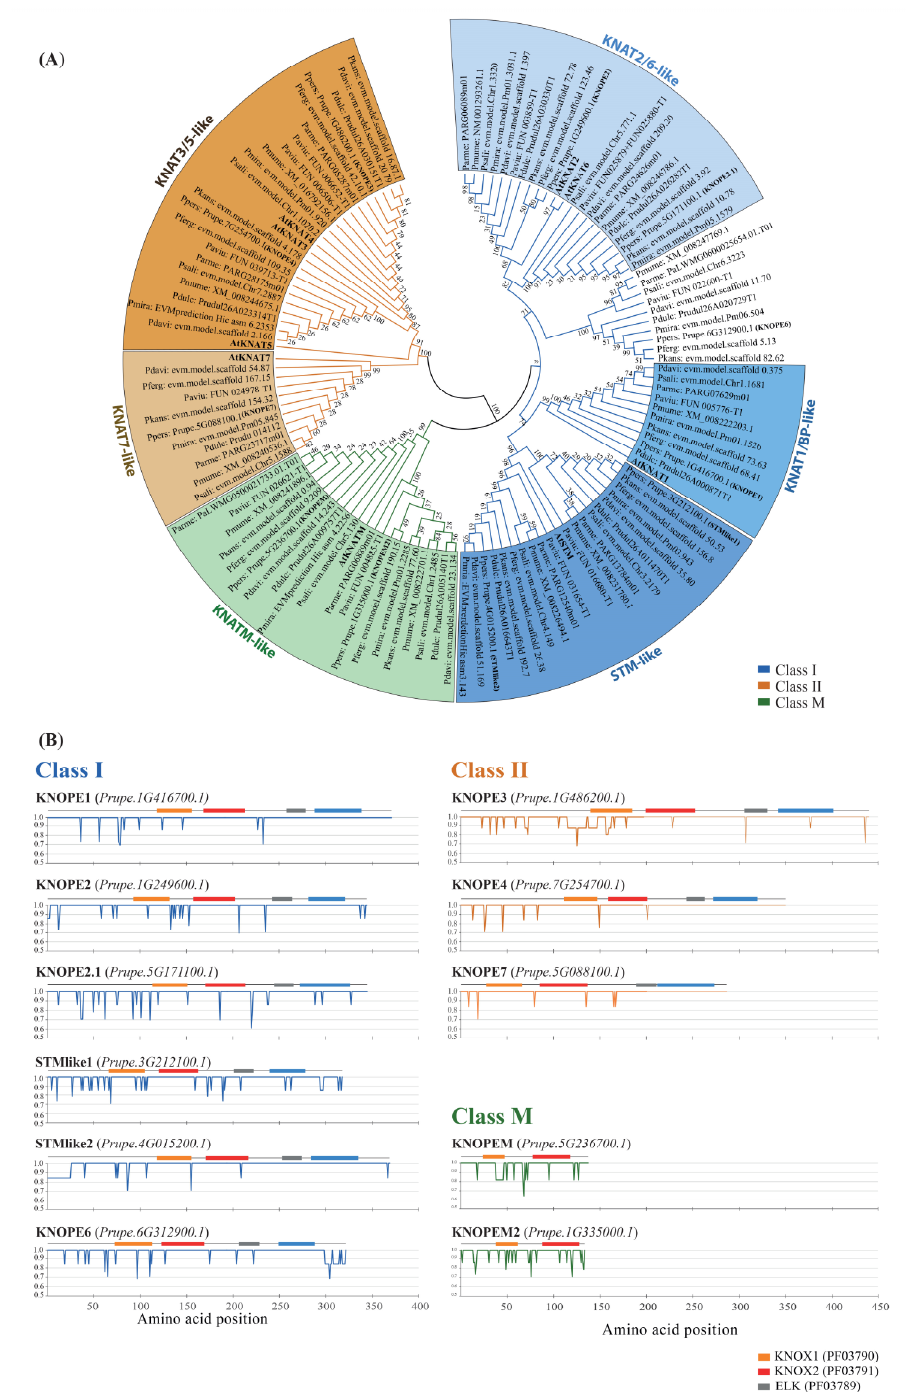
Figure 1. ( A ) Phylogenetic tree of PRUNOX deduced proteins, clustered into classes I, II, and M (blue, orange, and green shades) and named based on the presence of A. thaliana (bold) members in the clade. ( B ) Plots of amino acid variability within KNOX subgroups. The peach proteins were schemed (top of each panel) together with key domains (colored boxes) and used as reference for KNOX of other species. Identity variation (percent) of amino acids within Prunus spp. proteins (Y-axis) refers to amino acid positions (X-axis). Orange, KNOX1 (PF03790); red, KNOX2 (PF03791); grey, ELK (PF03789); blue, homeodomain (PF05920).